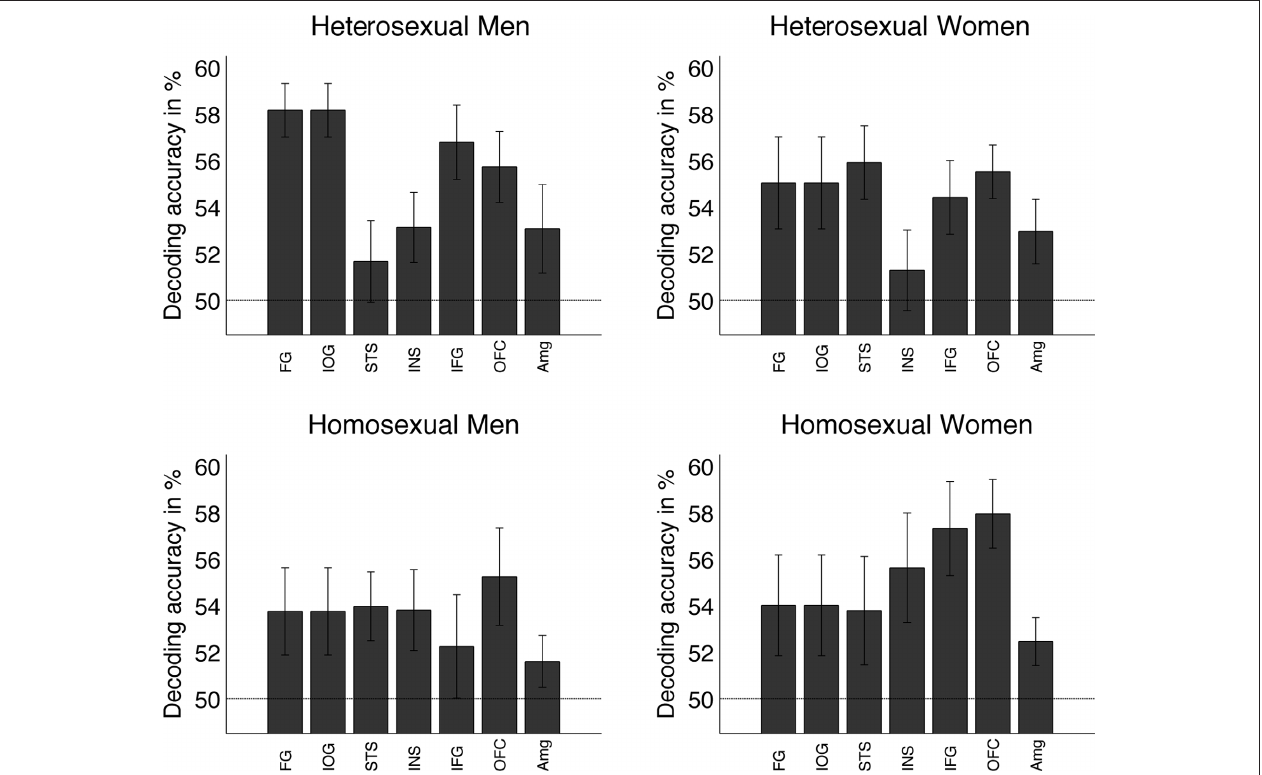
FIguRe 4 | Mean decoding performance as a function of the subject’s sexual preference. The decoding profiles in each group were similar to the mean averaged across the 40 participants shown in Figure 3A . Testing for differences between the groups, an ANOVA conducted separately for each ROI, revealed no significant differences in any of these